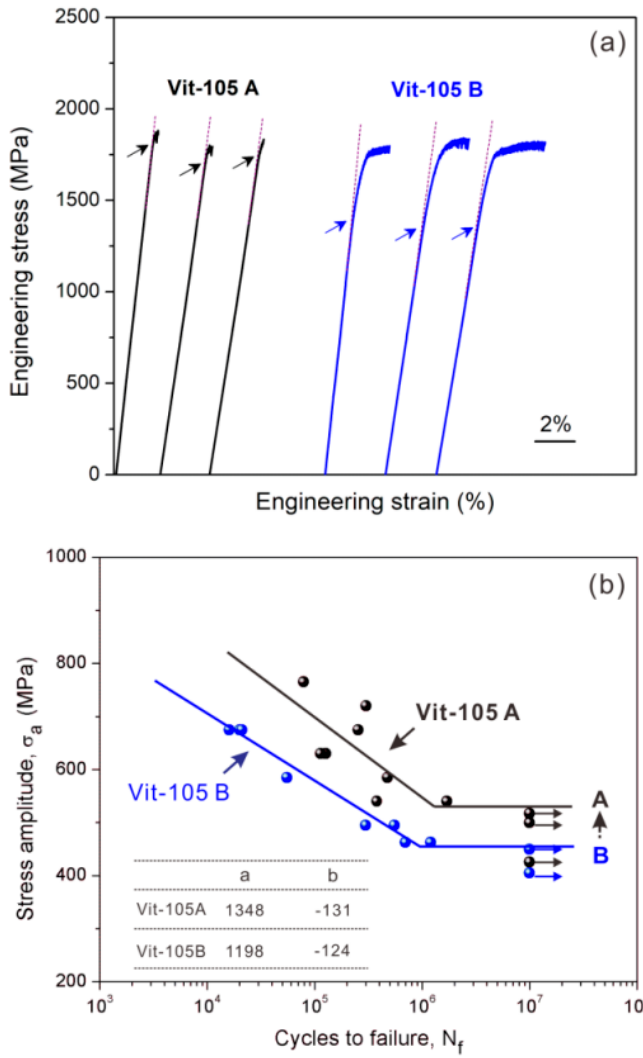
Figure 15. ( a ) Compressive engineering stress-strain curves of different batches of metallic glasses (MGs), i.e., Vit-105 A and Vit-105 B; ( b ) stress-life ( S-N ) fatigue data for the Vit-105A and Vit-105B MGs [58].